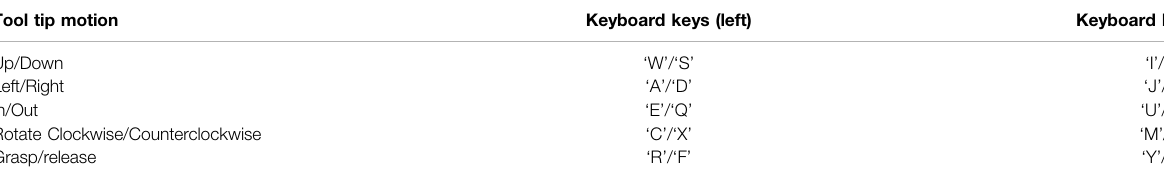
TABLE 1 | Keyboard keys for tool teleoperation.